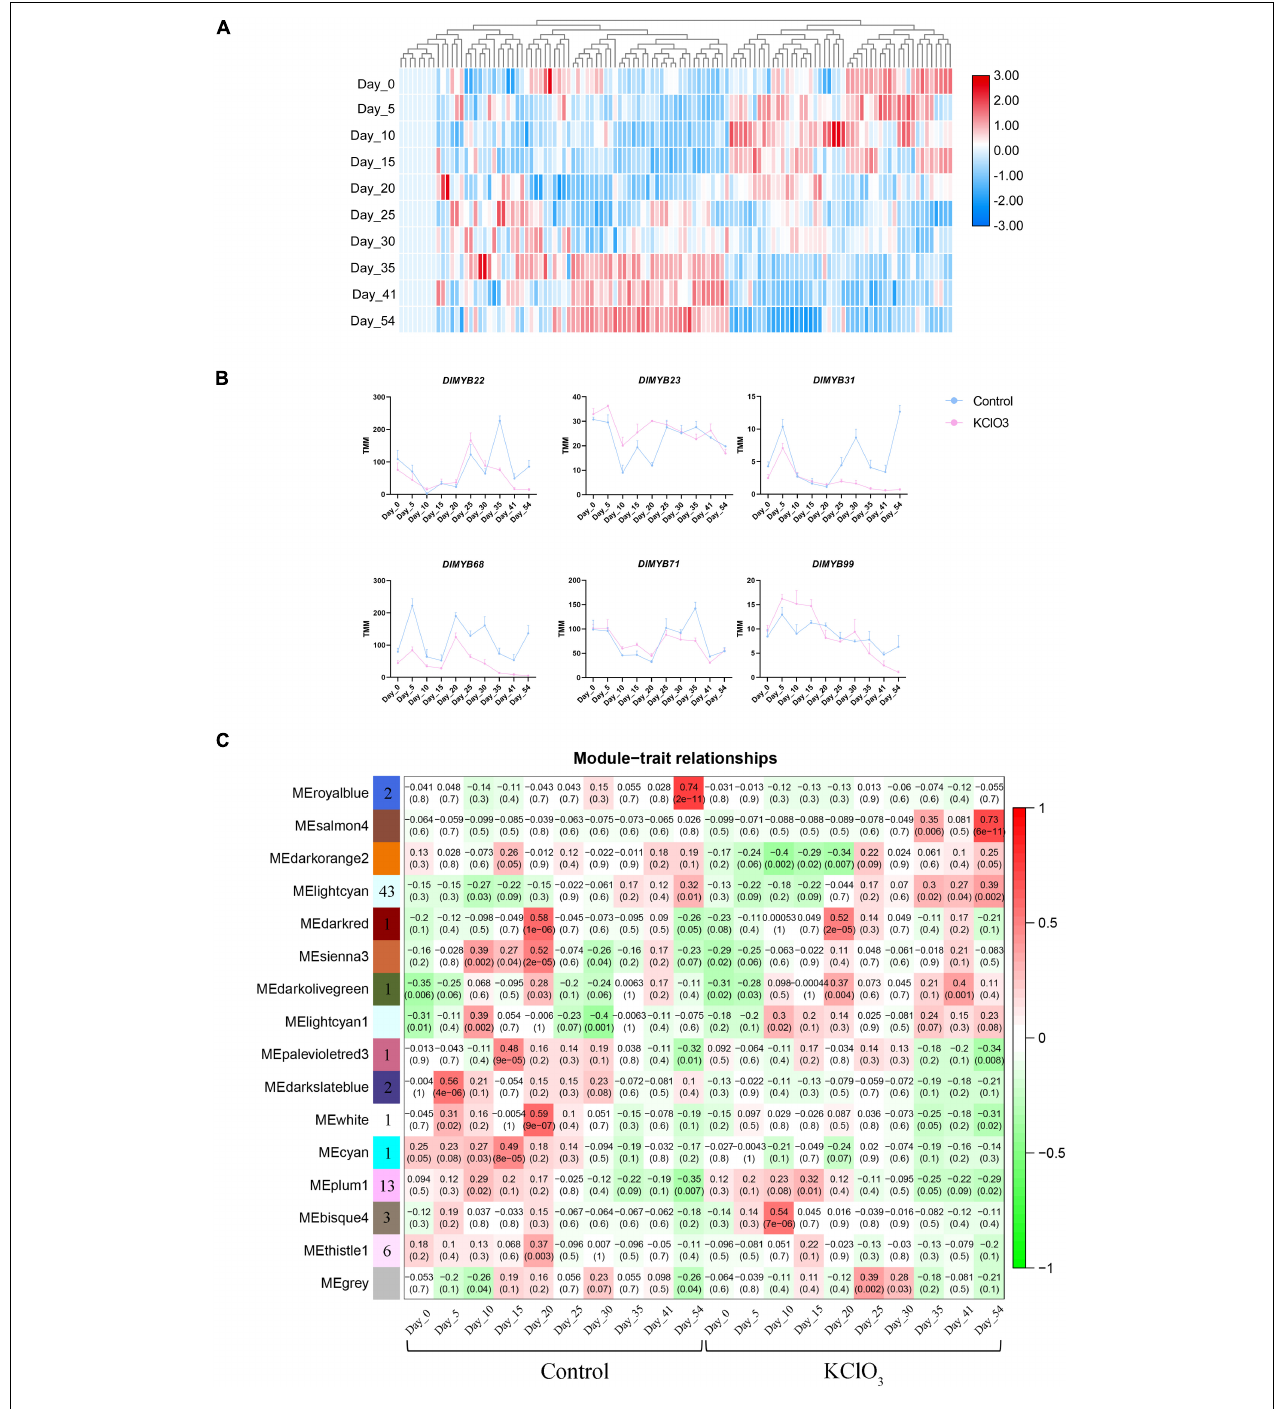
FIGURE 8 | Expression patterns of DlMYB genes under KClO 3 treatment. (A) The heat map displays the hierarchical clustering of the 119 DlMYB genes at different time points, with red indicating high expression levels and blue indicating low expression. (B) The line graphs display the effect of KClO 3 treatment on the expression of DlMYB genes. The blue line represents the control and the pink line represents KClO 3 treatment. (C) The heatmap from WGCNA of differentially expressed genes (DEGs) in off-season flower induction at different treatments and developmental stages. Each row corresponds to one module resulting from an WGCNA eigengene value. Each column corresponds to the control treatment and the KClO 3 treatment at different time-points. The color and number of each cell at the row-column intersection indicate the correlation coefficient between one specific module and one time point under control or KClO 3 treatment. Darker red represents a higher degree of correlation. The number in brackets indicate the significance ( p -value) of the correlation coefficient. The number of DlMYB genes in each module is shown in the leftmost column.